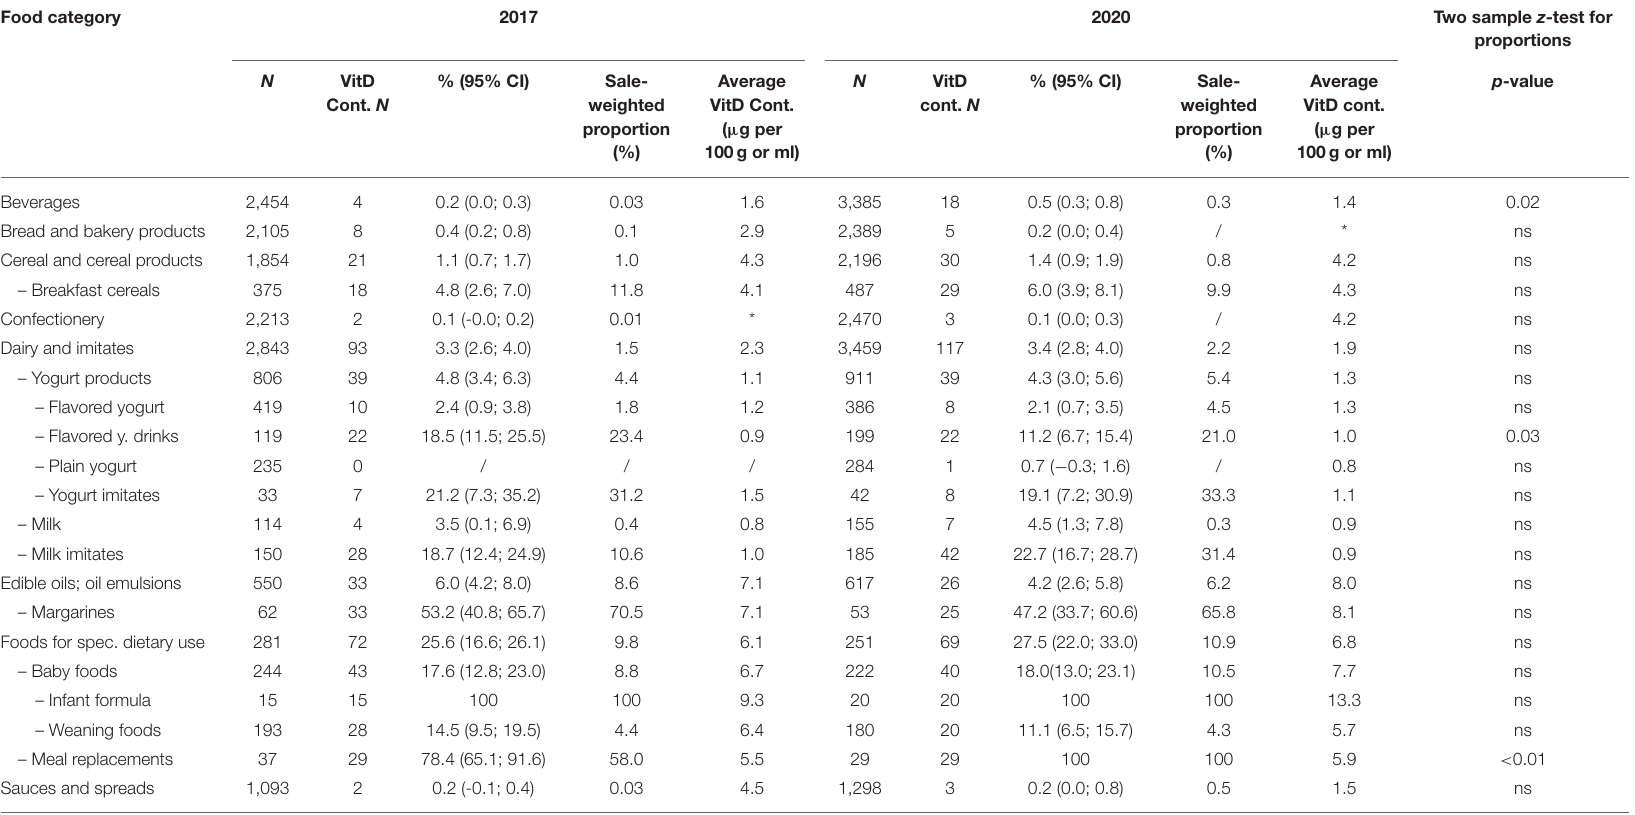
TABLE 1 | (Sub)category proportions of foods fortified with vitamin D in the food supply for 2017 and 2020 (Slovenia). Food